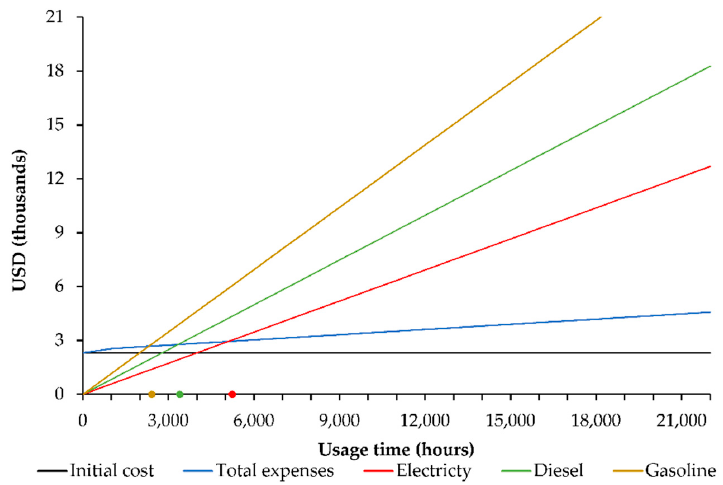
Figure 11. Break-even analysis of CSR.